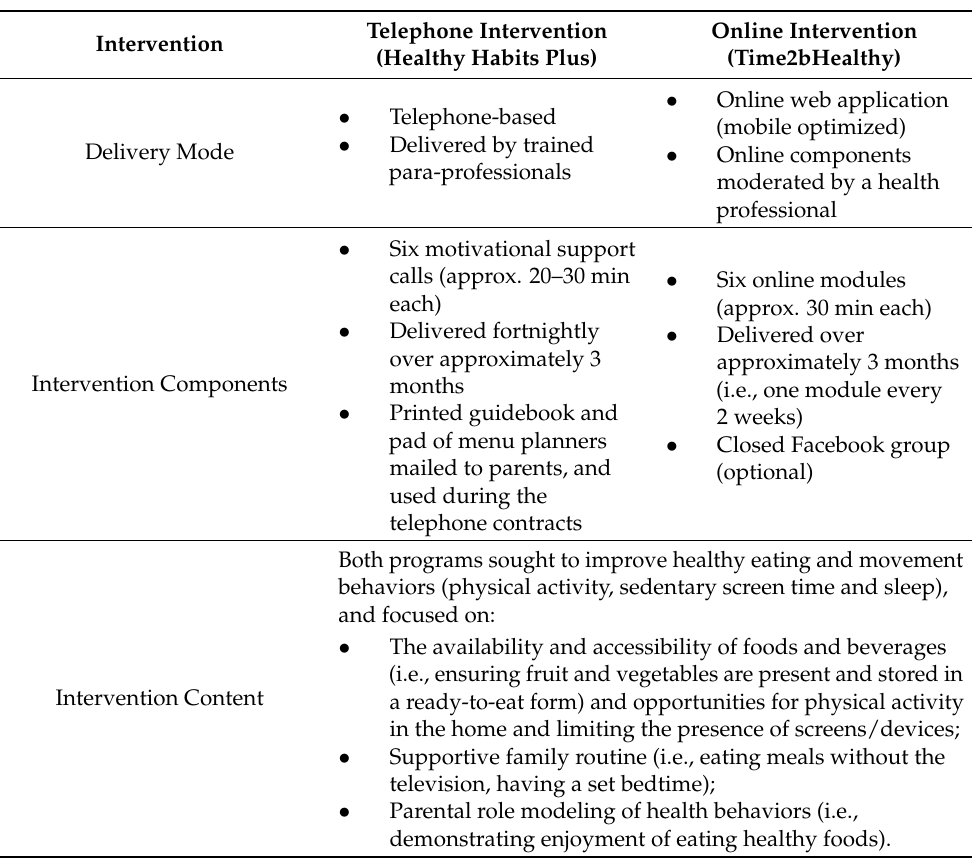
Table 1. Summary of interventions delivered as part of the ‘Time for Healthy Habits’ trial.